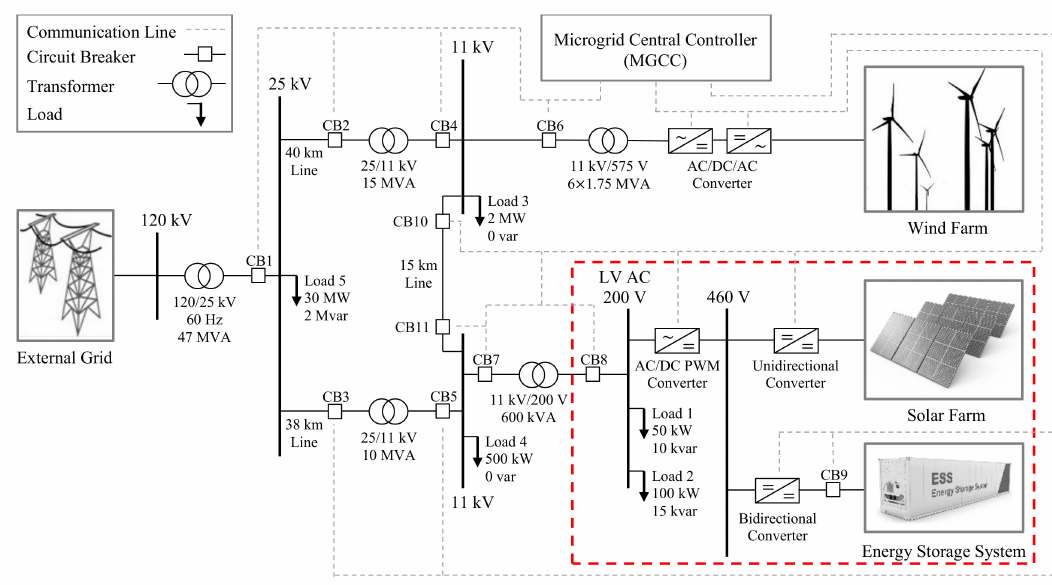
Figure 1. Single-line diagram of the considered hybrid